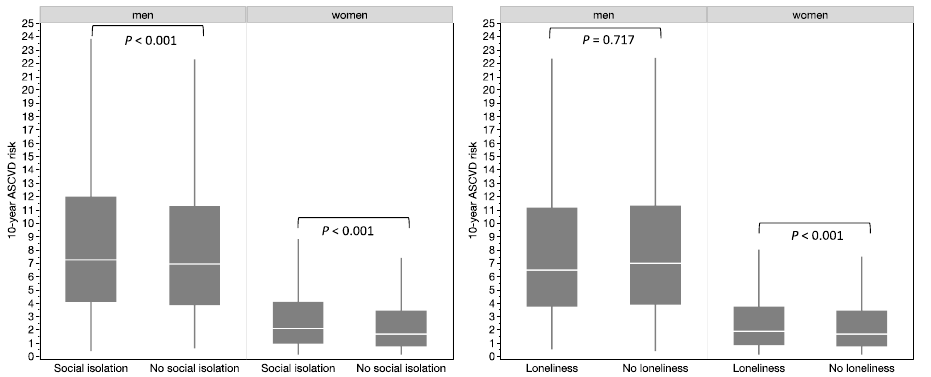
Figure 2. Estimated 10-year ASCVD risk according to gender and social isolation and loneliness status (white line: median; grey area: 25th to 75th percentile).